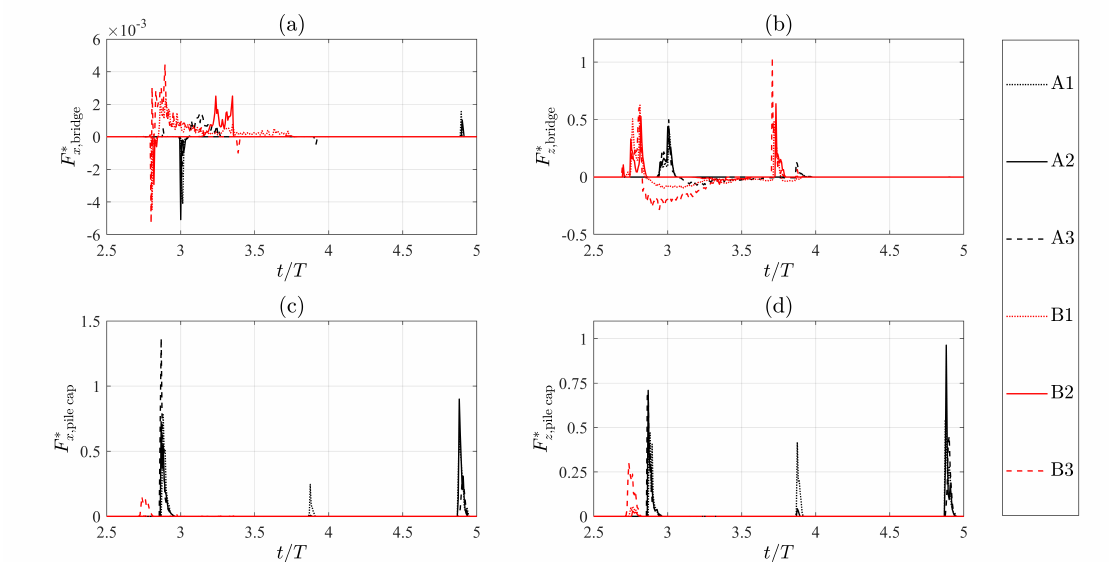
Figure 10. Time history of the normalized forces on the beam and pile cap for different tested wave conditions: ( a ) horizontal force on the pier beam, ( b ) vertical force on the pier beam, ( c ) horizontal force on the pile cap and ( d ) vertical force on the pile